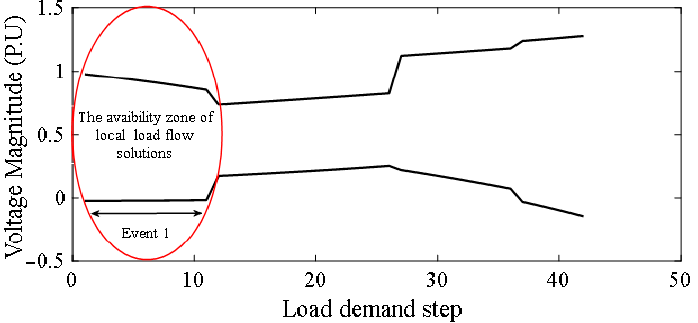
Figure 24. The voltage magnitude for bus one using the quadratic form in terms of the load demand.